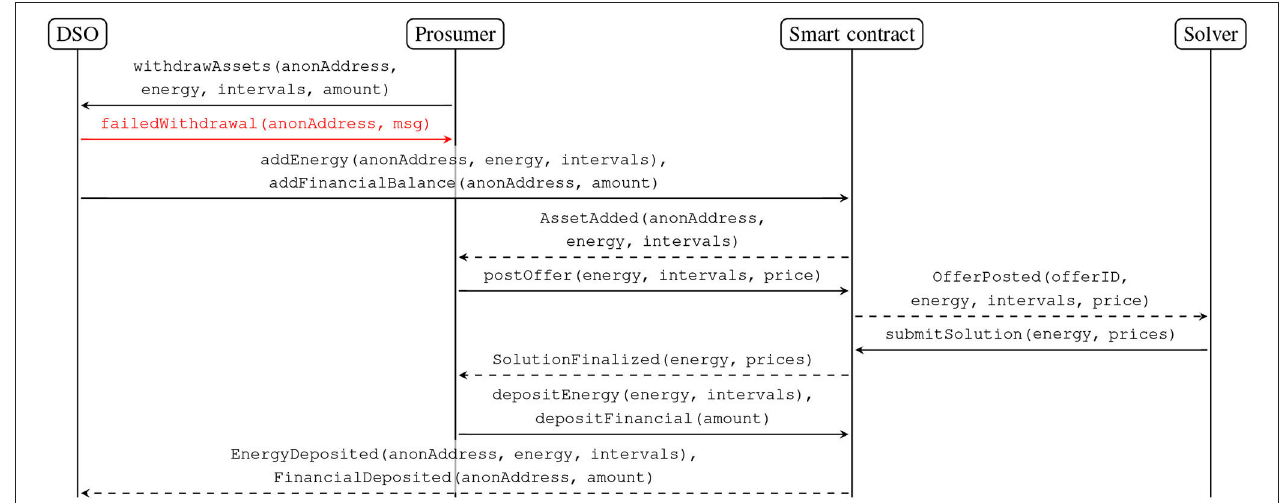
FIGURE 4 | Sequence diagram of the trading